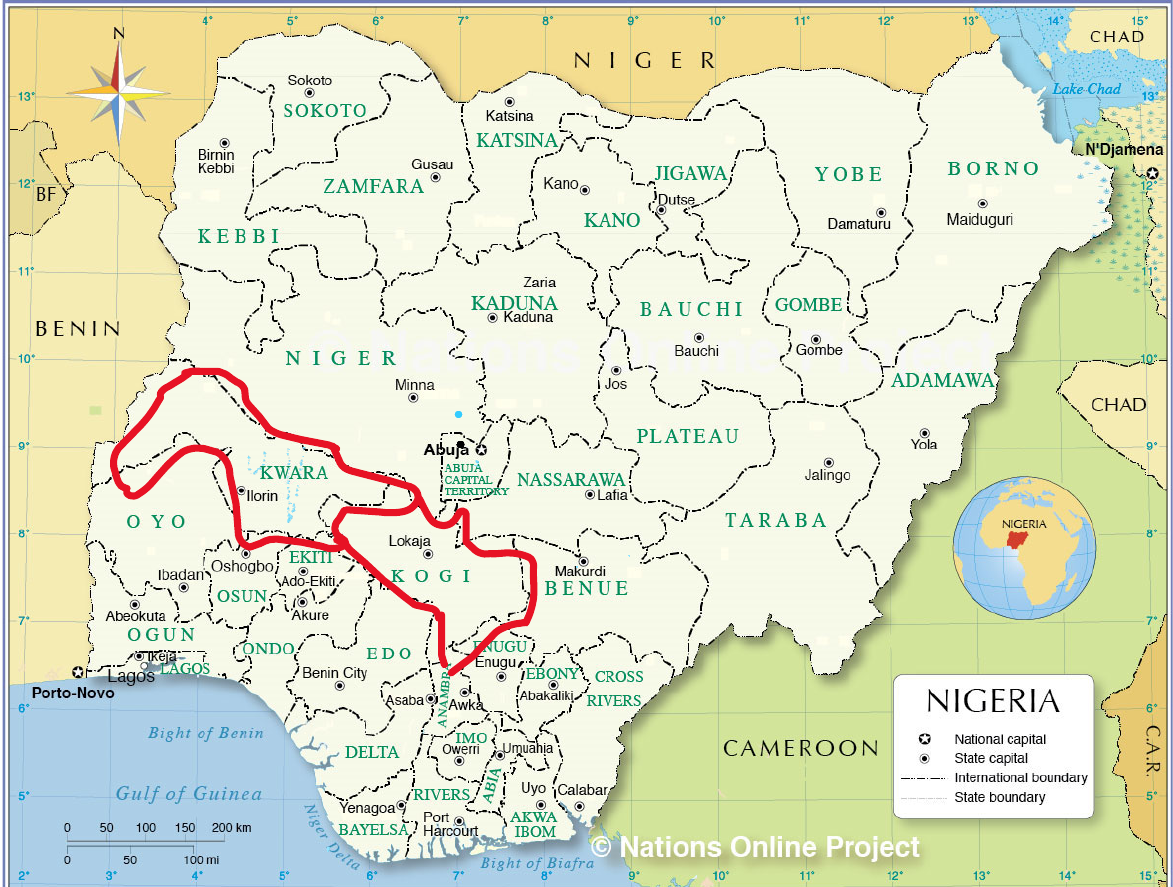
Figure 1. Map of Nigeria showing the states in Nigeria State. Source: UN Cartographic Section. Available from: https://www.nationsonline.org/oneworld/map/nigeria ‐ administrative ‐ map.htm, accessed on 13 December 2021.